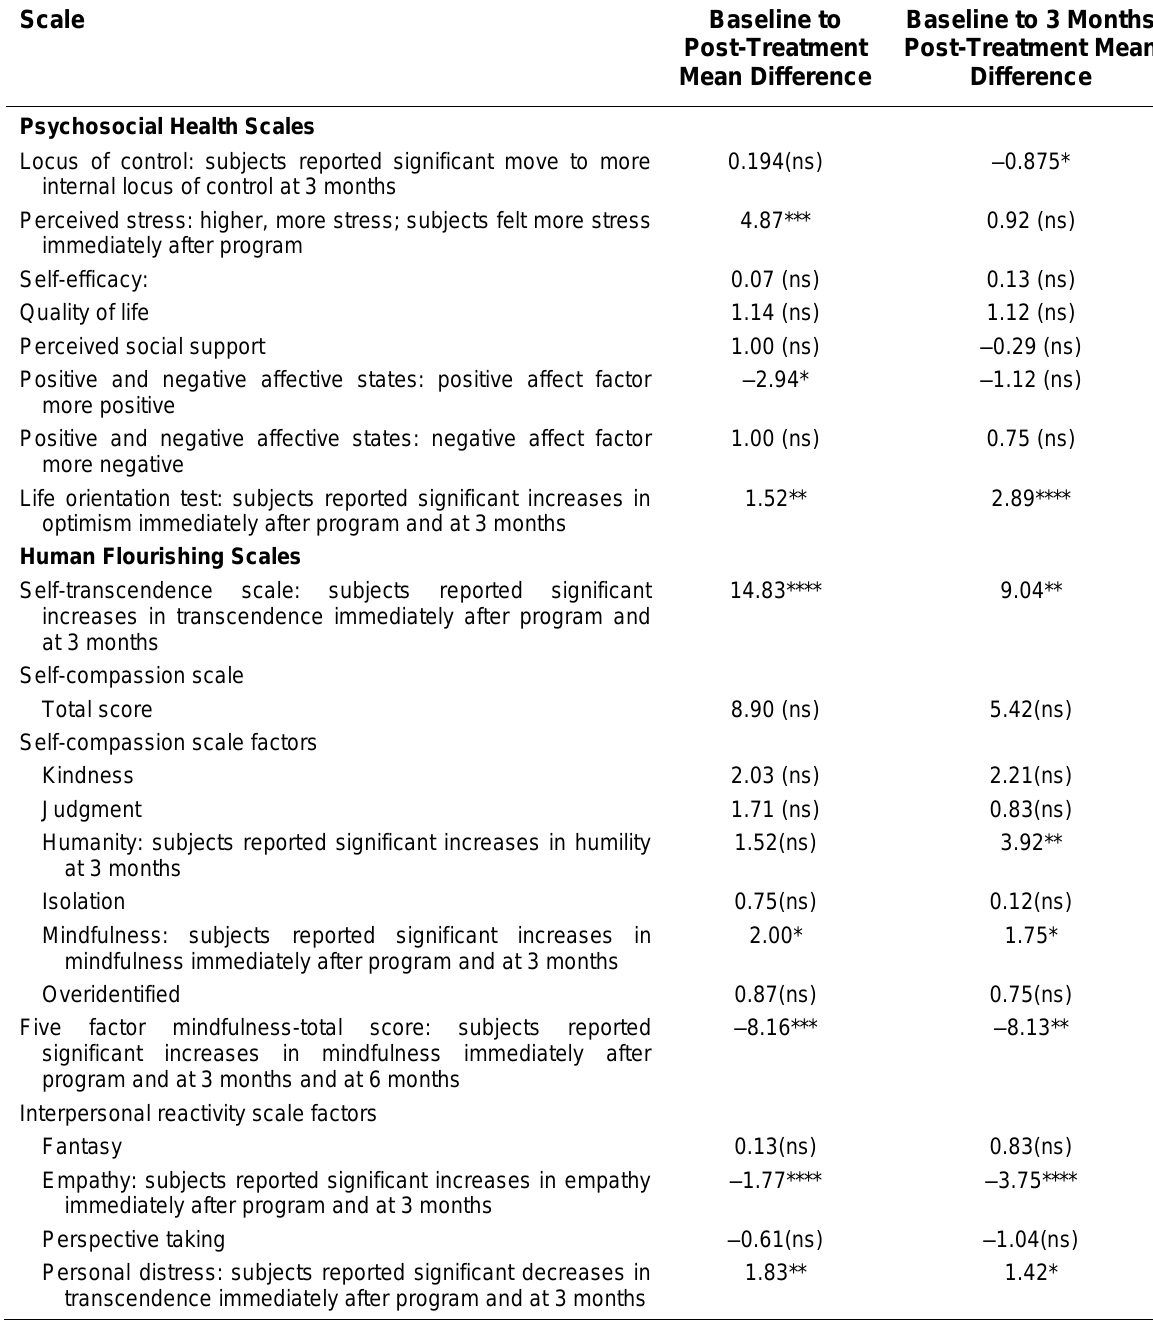
Measurements Utilized in Kripalu Yoga Teacher Training Outcomes